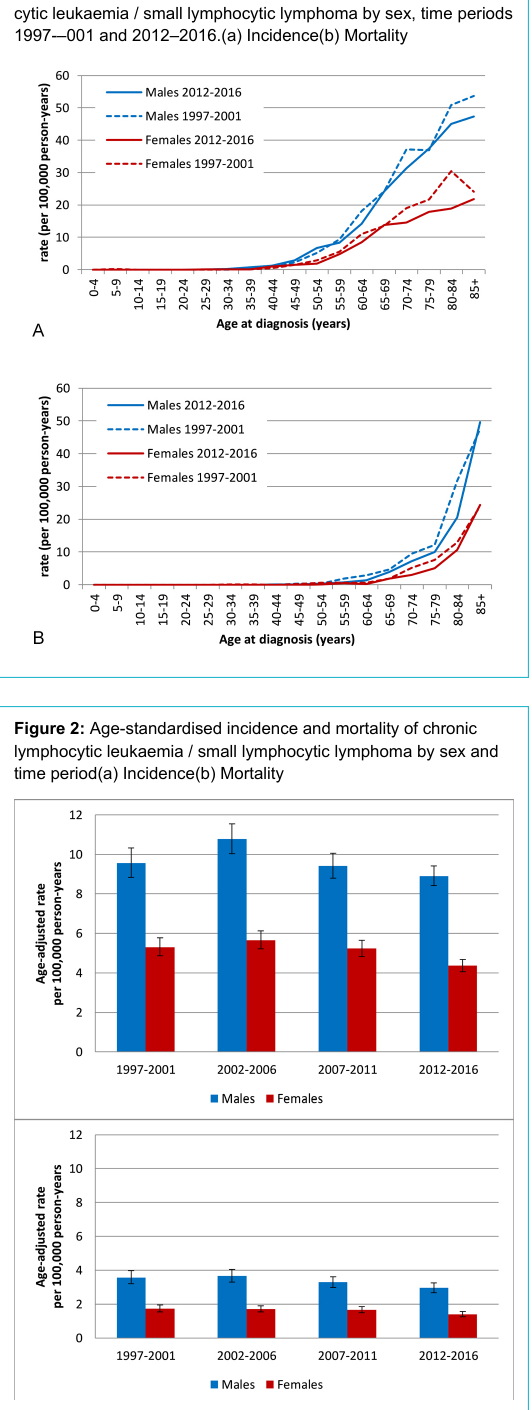
Figure 1: Age-specific incidence and mortality of chronic lympho- cytic leukaemia / small lymphocytic lymphoma by sex, time periods